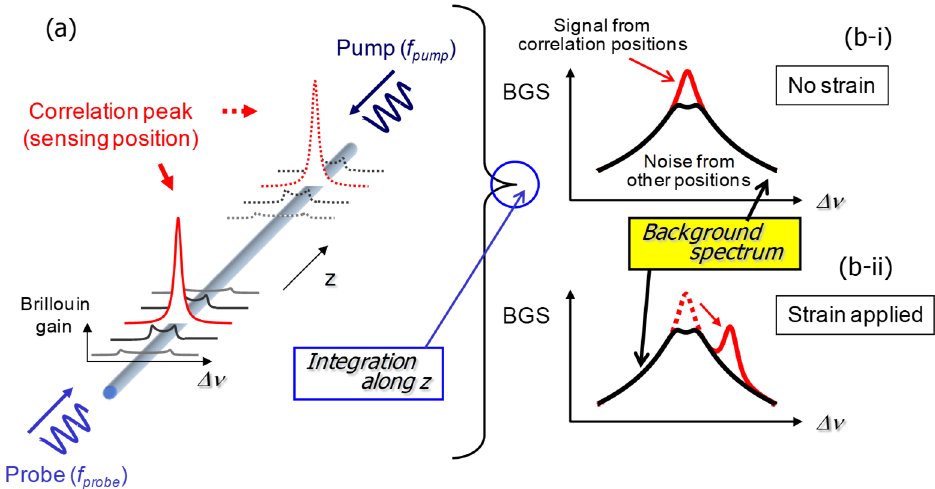
Figure 22. The spectral shape induced locally along the optical fiber by the BOCDA principle ( a ). At both sides of the correlation peak position, broadened spectra are generated that have large power portions at both edges of the spectrum. The BOCDA output spectrum is obtained by integrating all of the spectra that are generated at each position along the fiber ( b ). At the correlation peak position, a Lorenz-shaped signal spectrum is obtained, and a mountain-shaped background spectrum is generated as the integration of the spectra caused at the non-correlation portion.